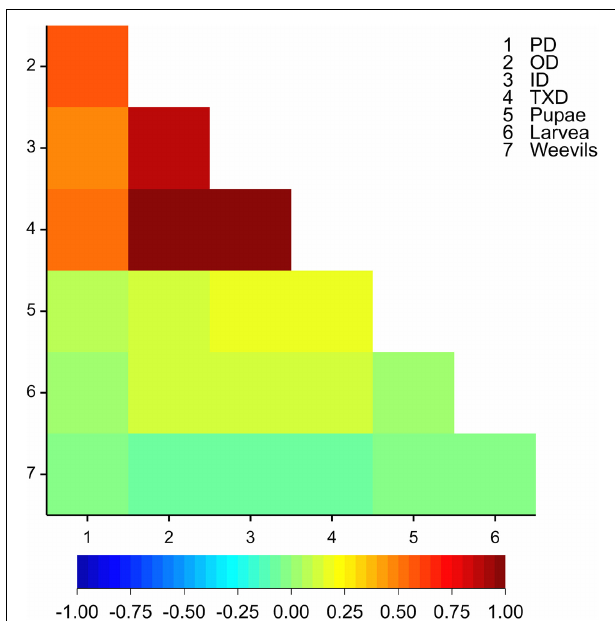
FIGURE 1 | A heat map of correlations (based on Pearson’s correlation coefficient) among the corm damage traits and the number of larvae, pupae, and weevils recovered at the end of the experiment. PD = peripheral corm damage, OD = outer cross-section corm damage, ID = inner cross-section corm damage, TXD = total cross-section corm damage.